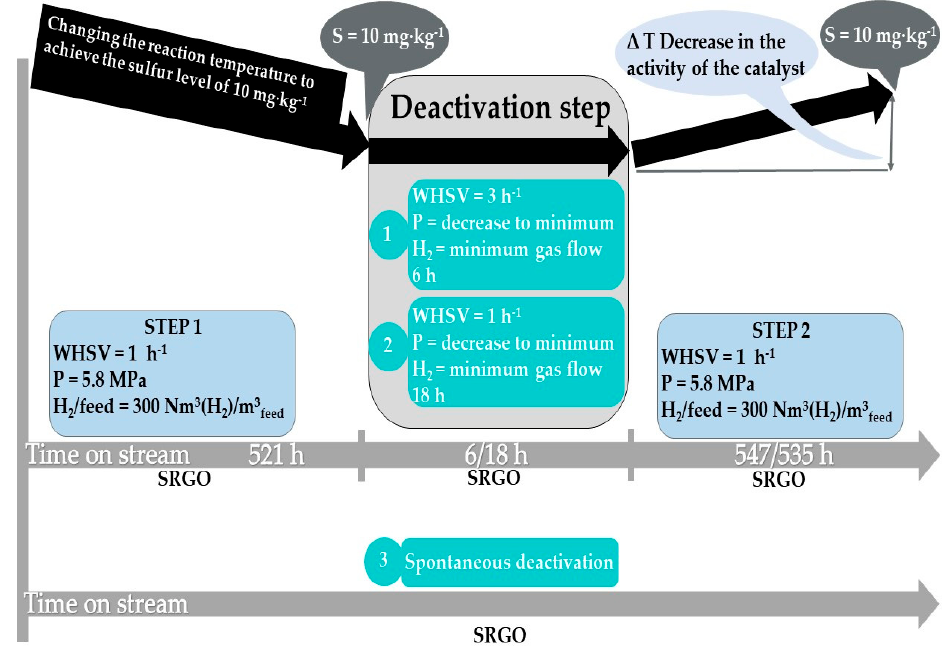
Figure 2. Diagram of catalyst testing.